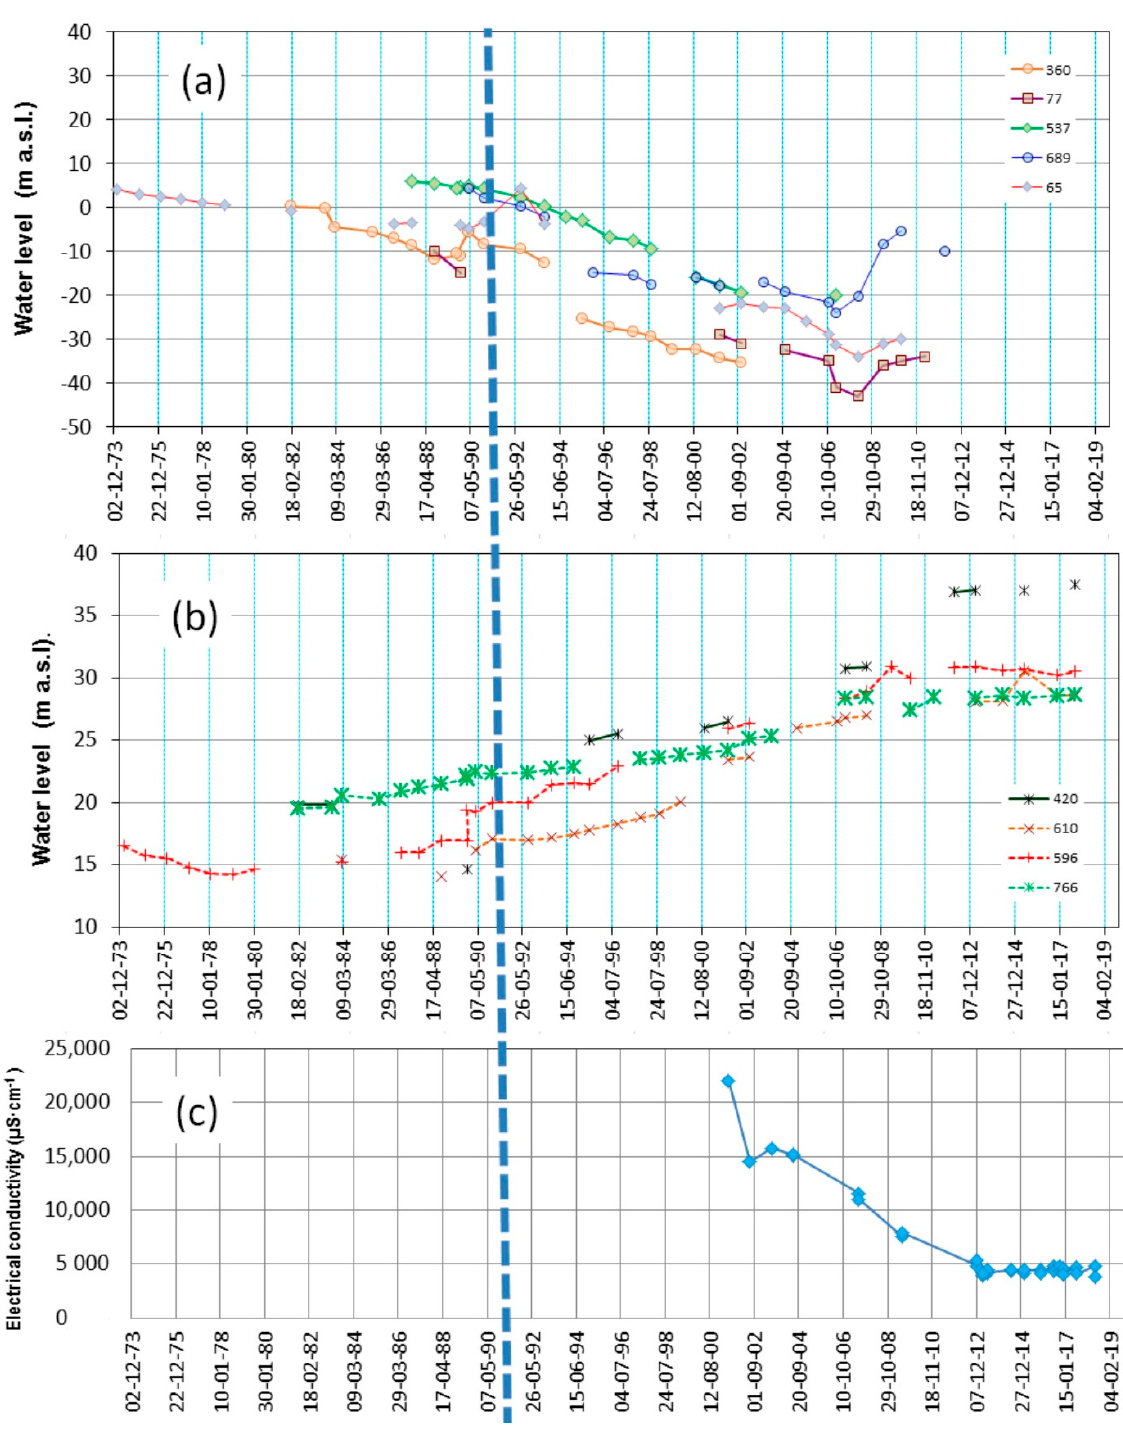
Figure 5. Historical evolution of water levels in the ( a ) deep aquifer, and in the ( b ) shallow aquifer location of the points in Figure 1, ( c ) surface water electrical conductivity in the Balsa del Sapo wetland. Point location in Figure 1. The vertical line corresponds to the date that separates the two periods defined, according to the evolution of surface water pumping.